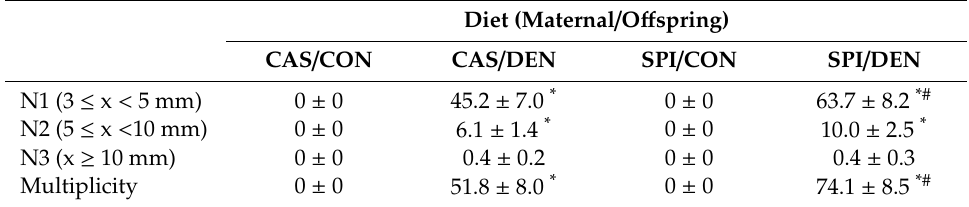
Table 1. E ff ects of maternal diet on body and organ weights of DEN-treated male rat o ff